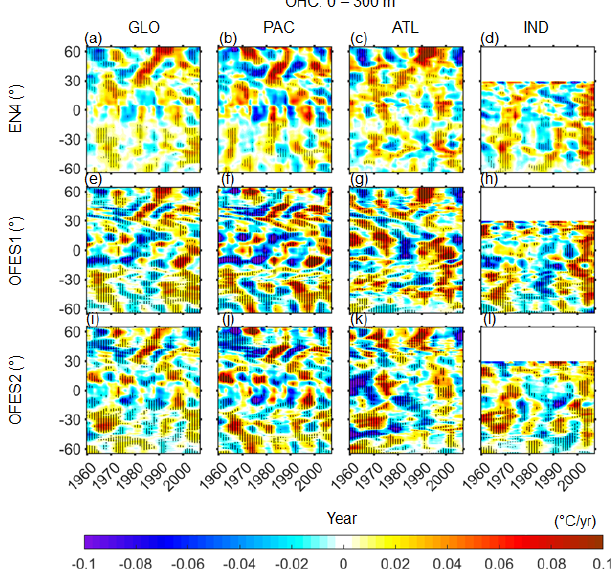
Figure 9. As for Fig. 8 but for the middle layer